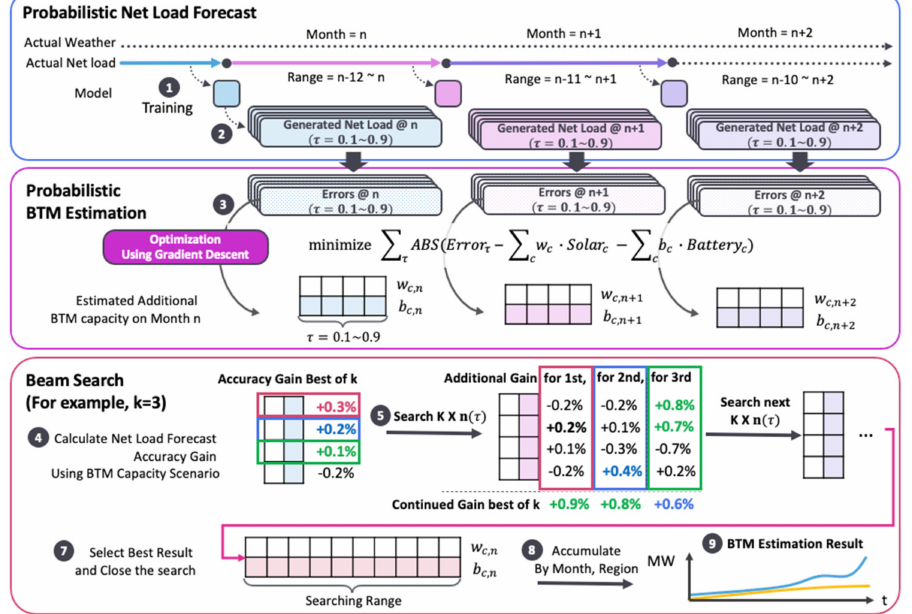
Figure 3. The overall procedure of the proposed BTM capacity estimation method using autoencoder based anomaly detection technique. As an example, one process is organized in order from step 1 to 7. Autoencoder is used to extract the likelihood distribution of gross load and its regenerated gross load is used to find additional BTM capacities.